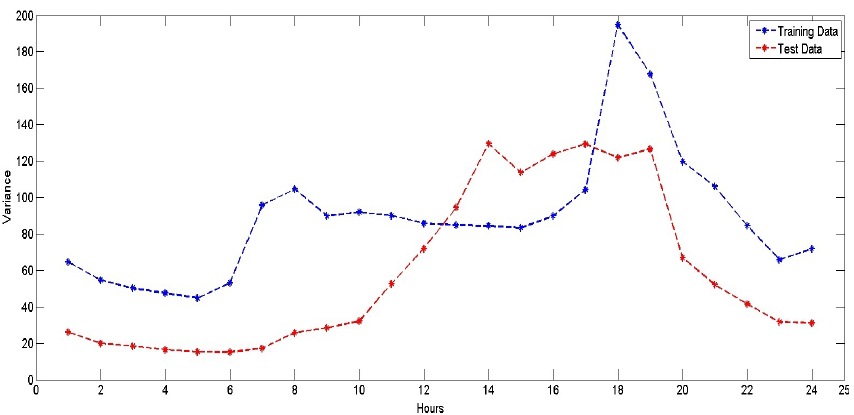
Figure 7. Hourly variance in training and testing data for NYISO (2008–2012).